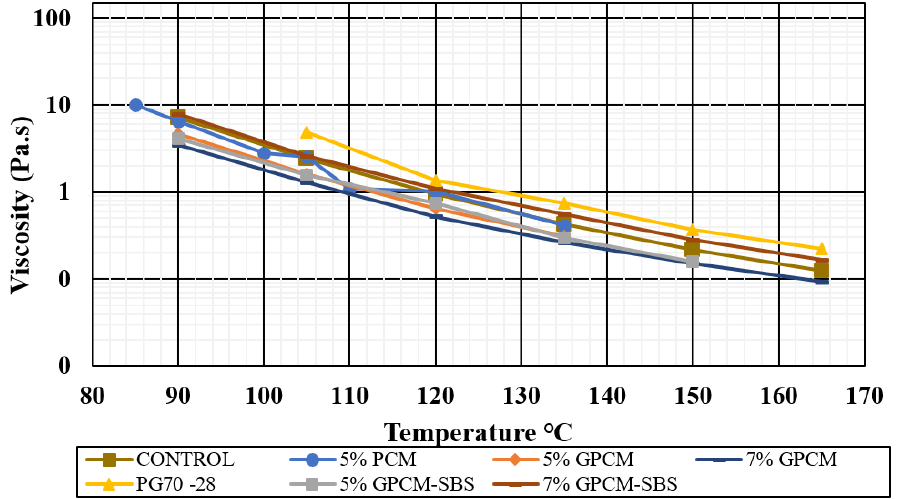
Figure 9 . Viscosity results for all binders . Figure 9. Viscosity results for all